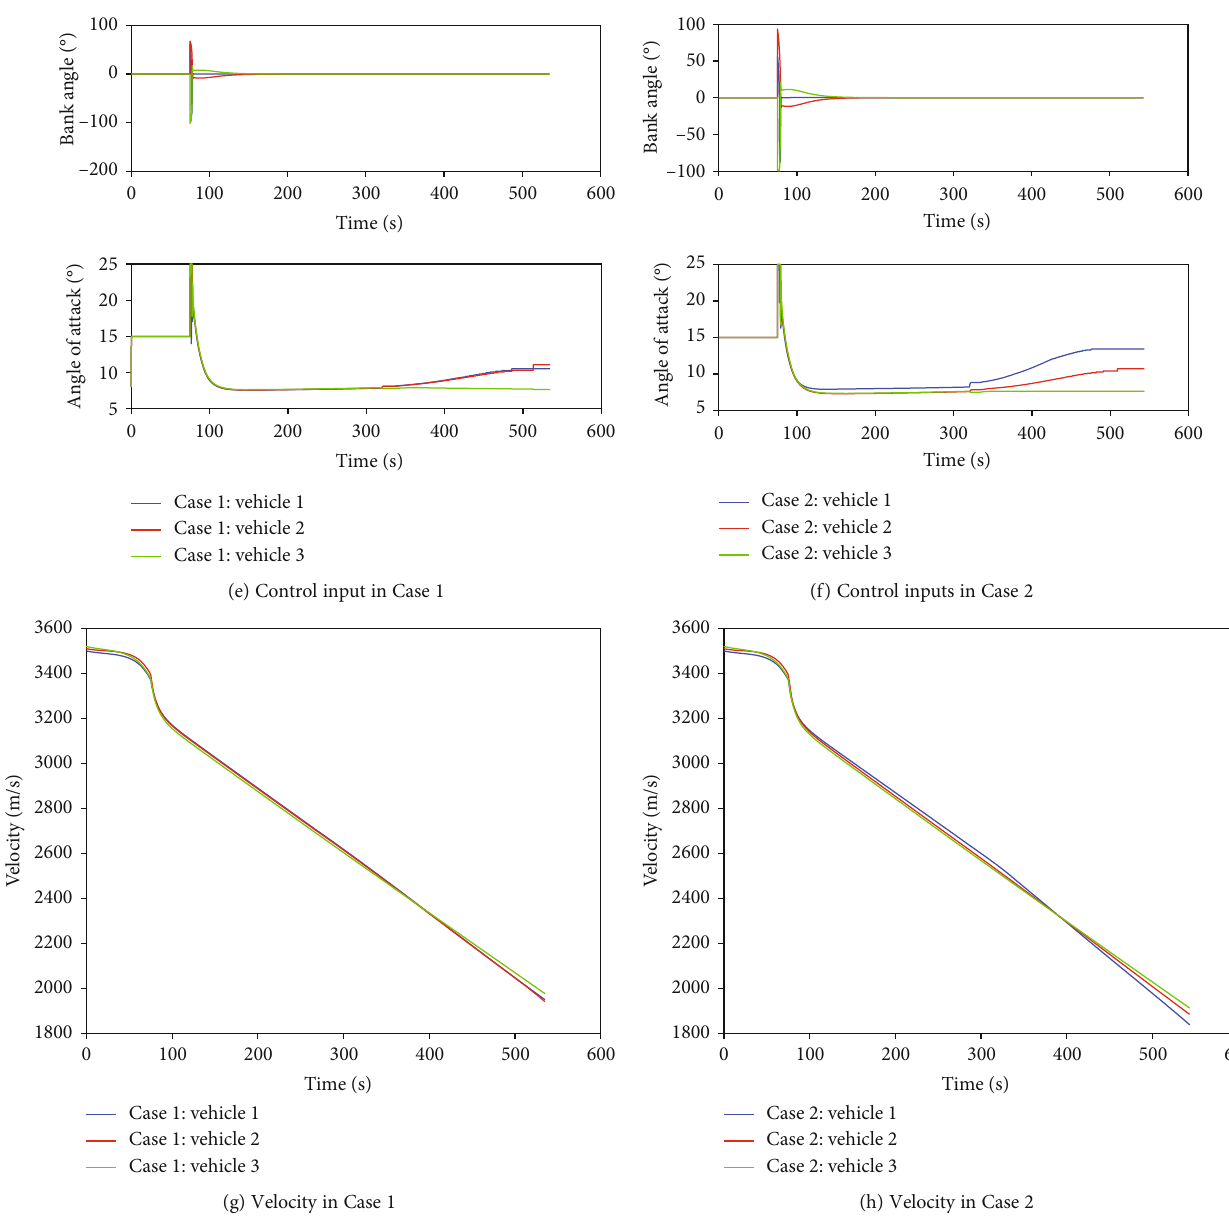
Figure 5: Simulation results of di ff erent formation con fi gurations. Table 3: Terminal times of di ff erent formation con fi